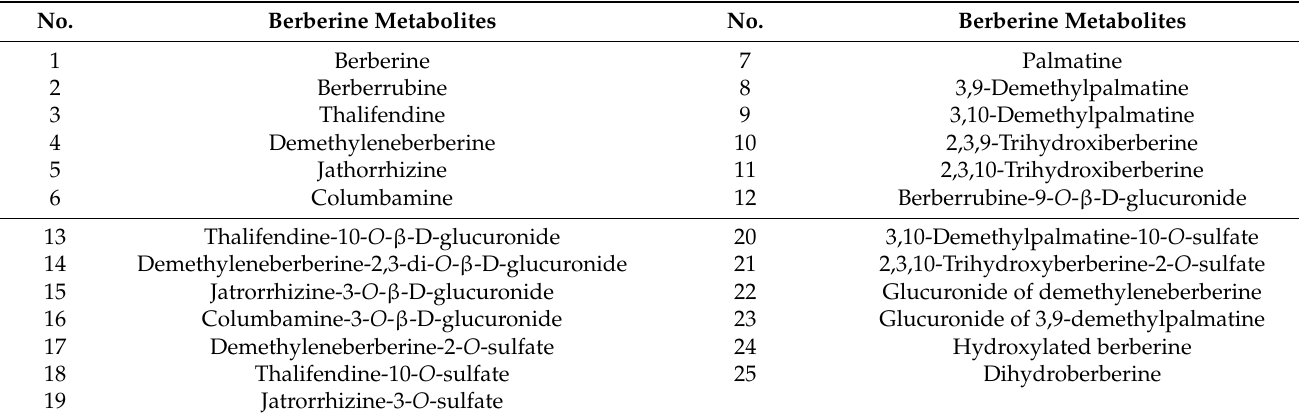
Table 1. Berberine and its